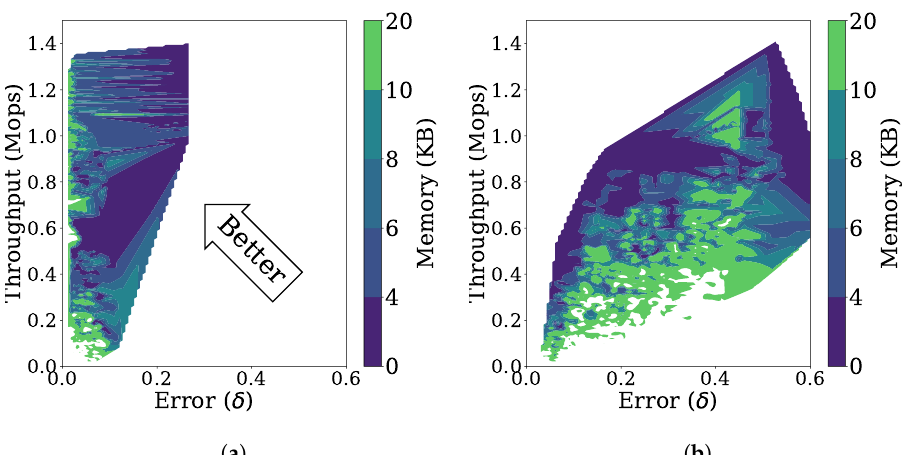
Figure 10. Performance of FlexSketch for various combinations of parameters’ values. ( a ) Stationary data stream. ( b ) Non-stationary data stream.